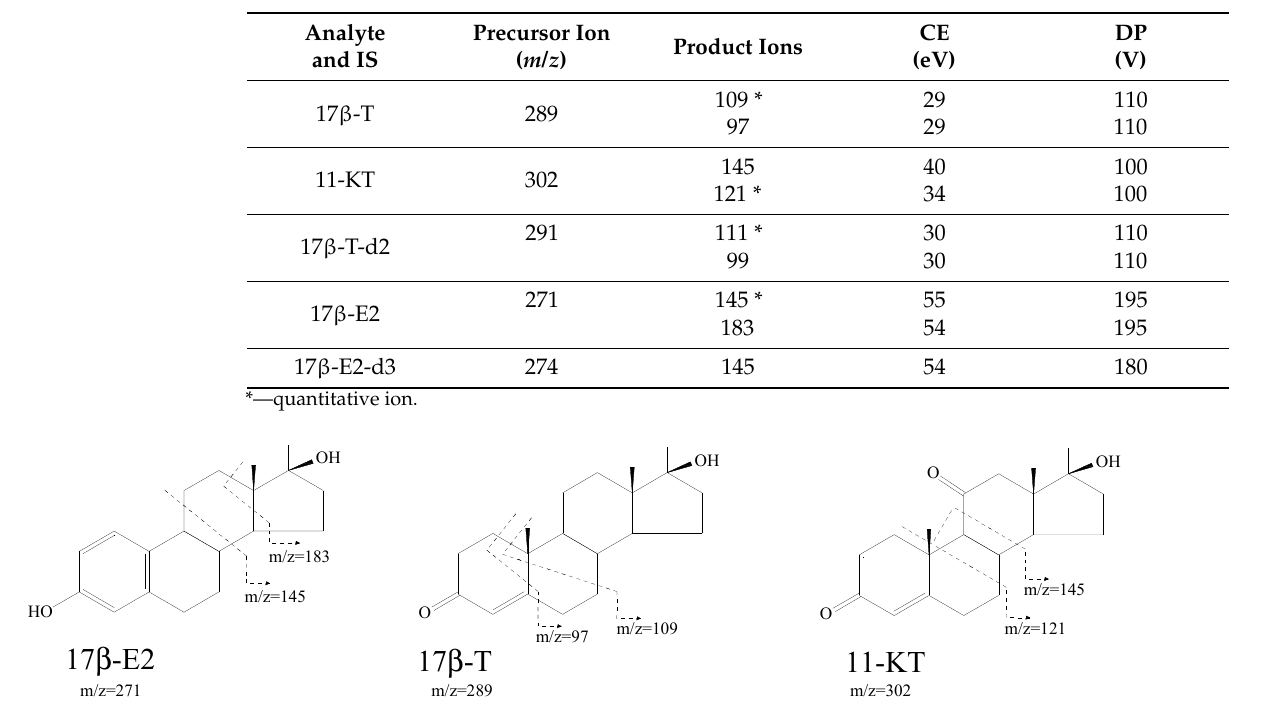
Table 2. Monitored ion of analytes and MRM parameters.